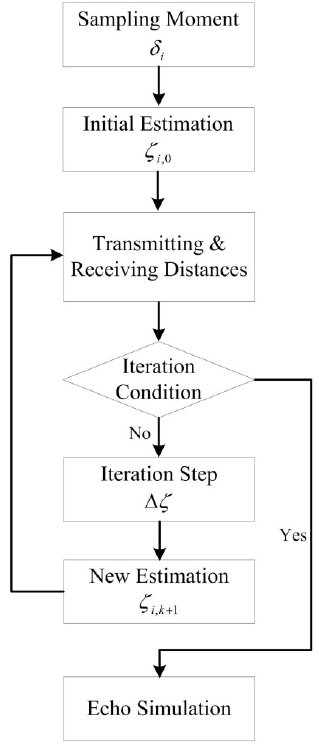
Figure 10. A workflow diagram of the simulation method. The core of the flow chart is to accurately estimate the transmitting moment corresponding to every sampling moment within the synthetic aperture time. Afterwards, the transmitting and receiving distances can be calculated and substituted into the echo expression to achieve simulated echoes.